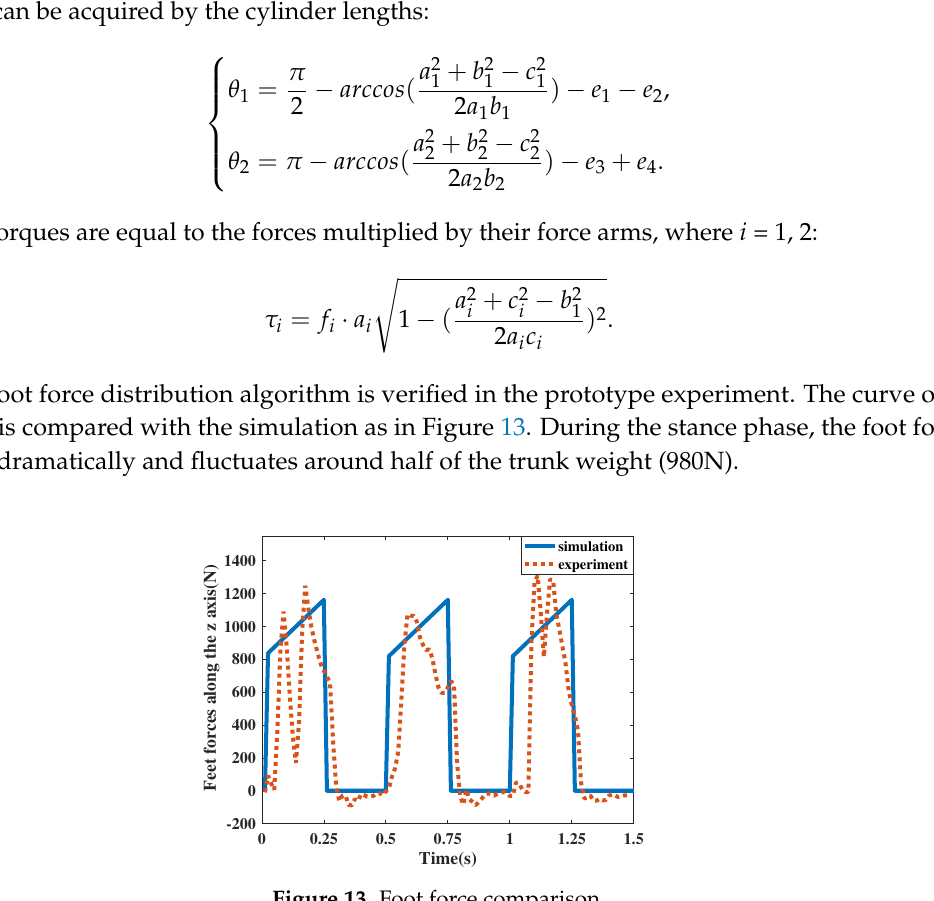
Figure 13. Foot force comparison.